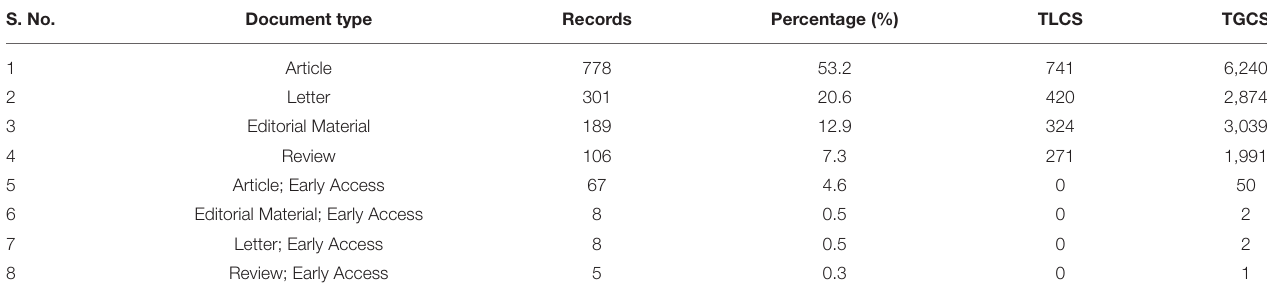
TABLE 1 | Distribution of included publications by document type in COVID-19 and PPE. S. No.